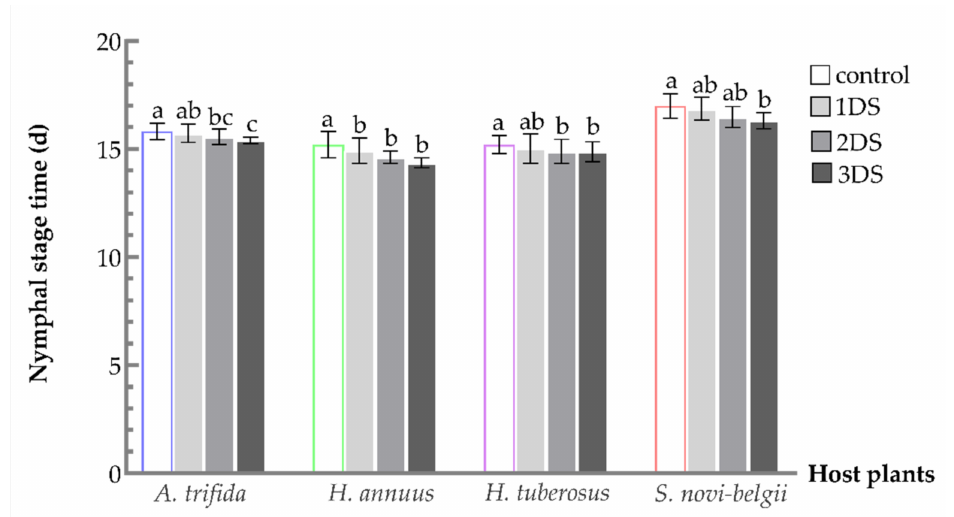
Figure 2. Total nymphal stage time of C. marmorata suffering from food deprivation on four host plants. Control: the group offered host leaflets continuously without food deprivation; 1DS: the group subjected to 1 day’s starvation; 2DS: the group subjected to 2 days’ starvation; and 3DS: the group subjected to 3 days’ starvation. Values are the mean ± SD. Different lowercase letters “a, ab, b, bc, c” in one species of host plants indicate significant differences (one-way analysis of variance followed by Duncan’s test, p <